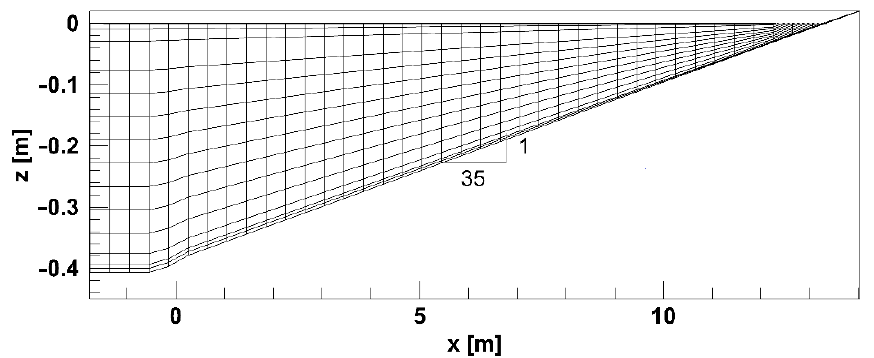
Figure 2. Computational domain (only one line out of every six is drawn in the horizontal direc- tion).